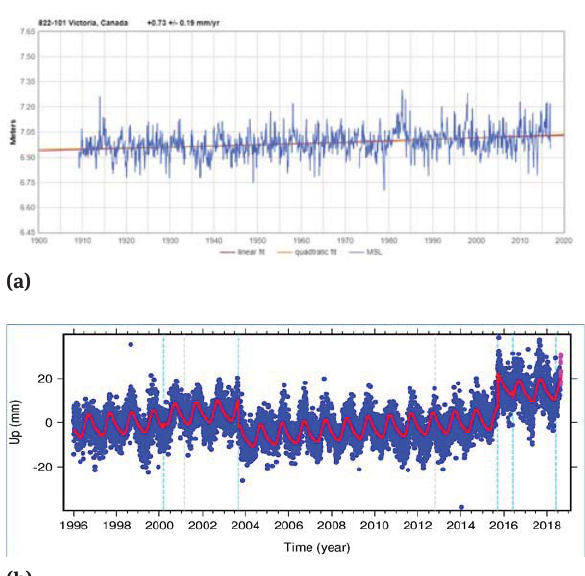
Figure 10: (a) MSL data for Victoria, Canada. Image reproduced modified after [4]. (b) GNSS time series for ALBH. Image reproduced modified after